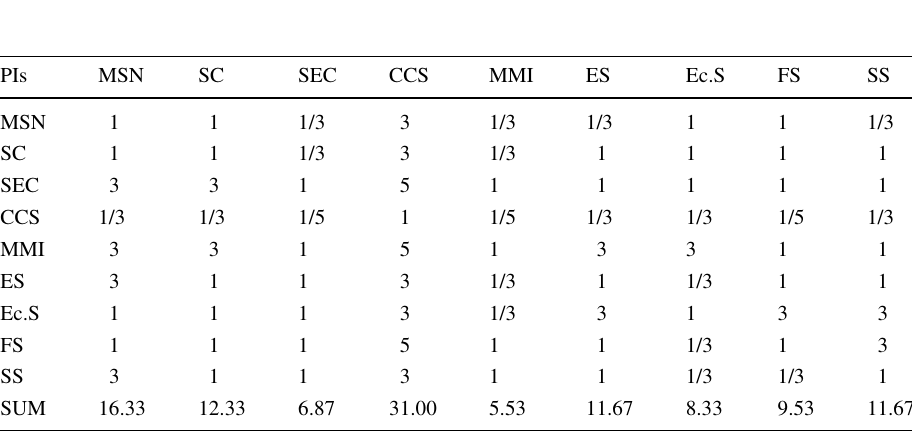
Reciprocals of above nonzero